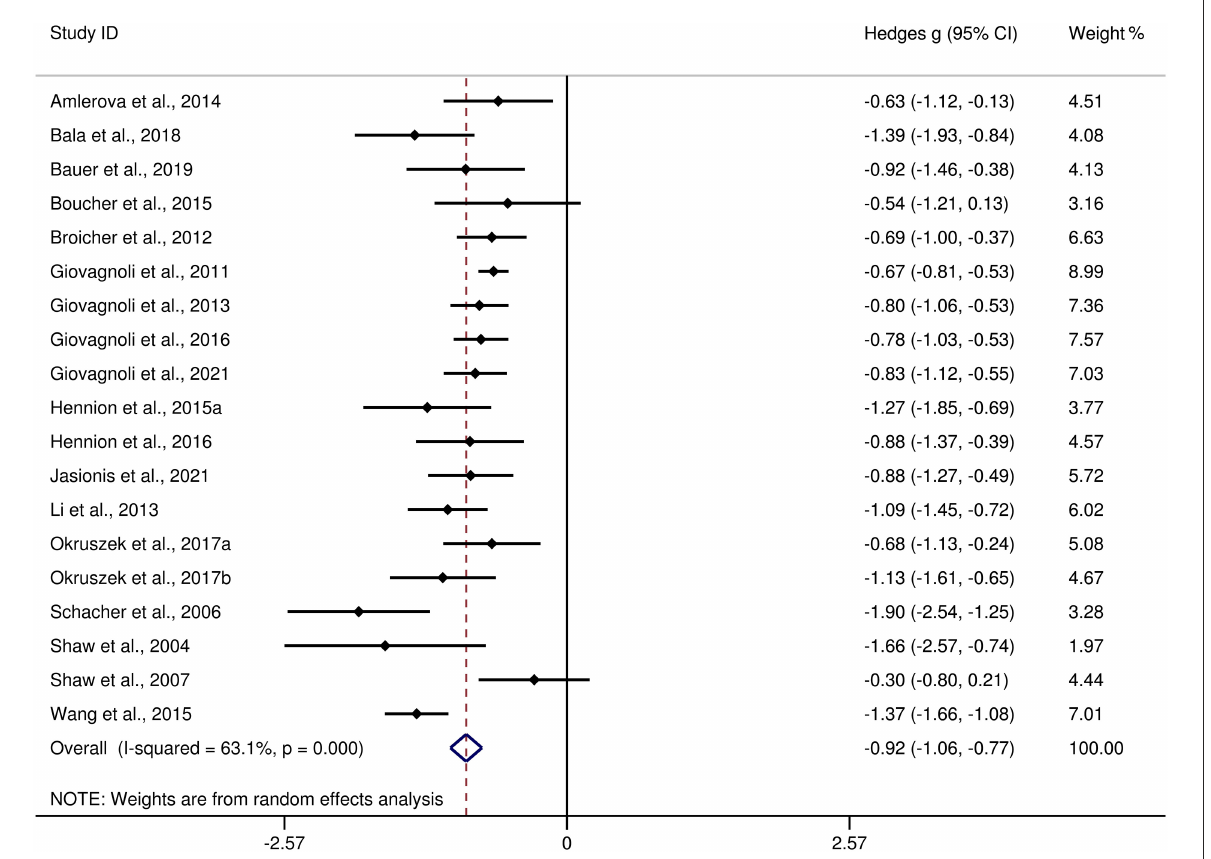
FIGURE2 Forest plots showing effect size estimates (Hedges g) for ToM differences between adults with TLE and healthy controls. ToM, theory of mind; CI, confidence interval; TLE, temporal lobe epilepsy.